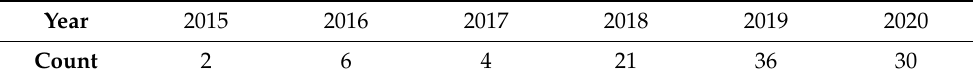
Table 1. Number of DNN-NILM publications based on low frequency data per year. Numbers are compiled based on Table 2. That means the number for the year 2020 corresponds to the publications until end of November, see Section